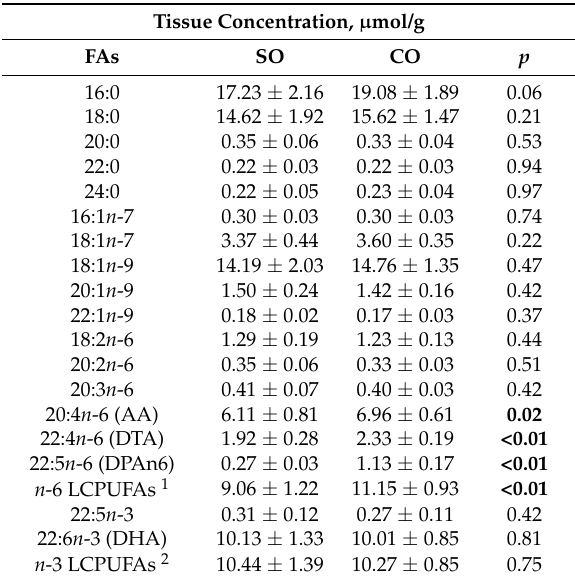
Table 2. Fatty acid concentration in the cerebellum of juvenile male rats.